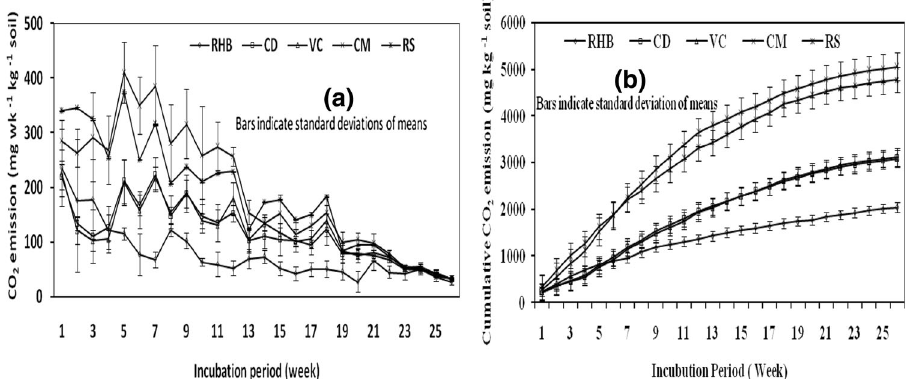
Fig. 1 CO 2 emission from different organic materials during 26 weeks of incubation: a trend and b cumulative emission. RHB rice husk biochar, CD cow dung, VC vermicompost, CM chicken manure, RS rice